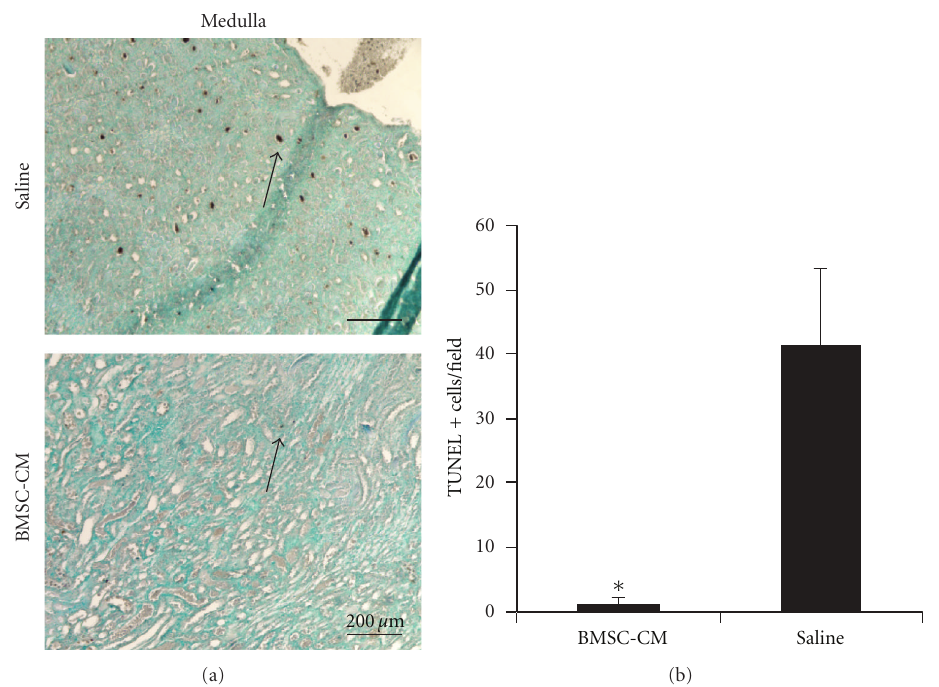
Figure 4: BMSC-CM prevents apoptosis in the outer medulla. (a) TUNEL staining was performed on sections of formalin fixed and para ffi n- embedded kidneys from rats administered a lethal dose of cisplatin (7.5 mg/kg) and sacrificed at 5 days following cisplatin administration. The arrows indicate TUNEL positive cells. The rats were treated at 3, 9, 24, 48 and 72 hours following cisplatin administration, with 1 mL of either physiological saline ( n = 4), or BMSC conditioned medium ( n = 3) i.v. (b) Quantification of the TUNEL positive cells per field of view. Scale bar = 200 μ m. ∗ P < 0 . 01 by Student’s T -test.